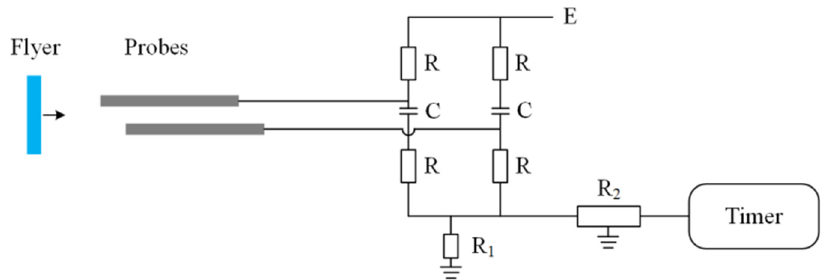
Figure 19. Schematic diagram of electric probe method.